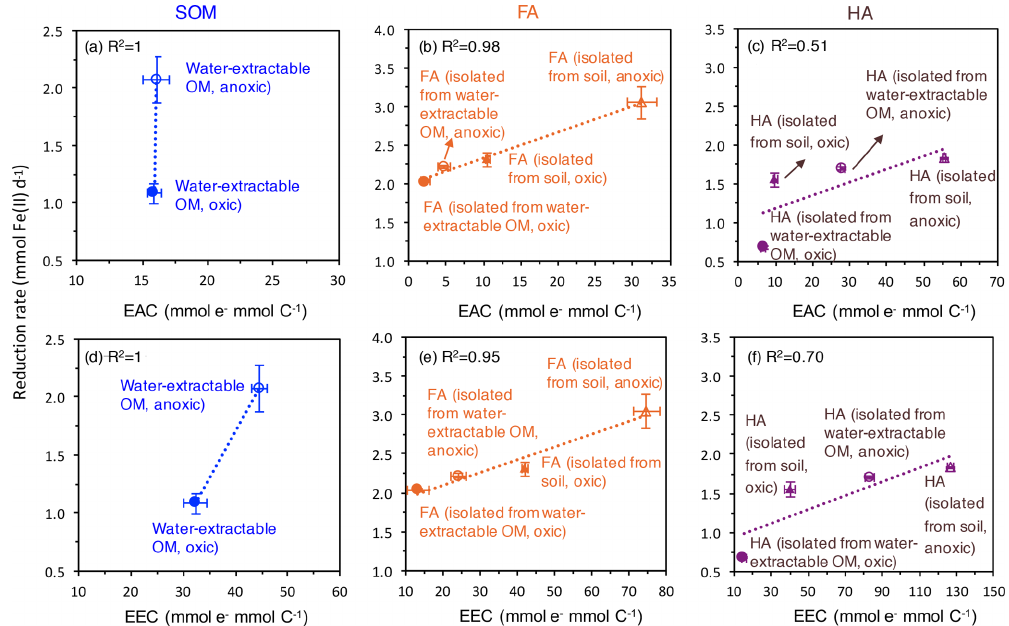
Figure 5. Correlation of the electron-exchange capacity (EEC) (d, e, f) and electron-accepting capacity (EAC) (a, b, c) with the fastest microbial ferrihydrite reduction rates ( Shewanella oneidensis MR-1) in the presence of oxically and anoxically prepared SOM (a) , FA (b) , and HA (c) . EEC and EAC values are replotted from Fig. 2. Please note that the EEC and EAC values were determined by the electrochemical method described in the Methods section and represent the contribution of both redox-active organic functional groups such as quinones and the redox-active Fe ions in the SOM, FA, and HA extracts. Horizontal error bars represent standard deviations of the measured EEC values; vertical error bars are standard deviations of the reduction rates calculated as shown in Fig.